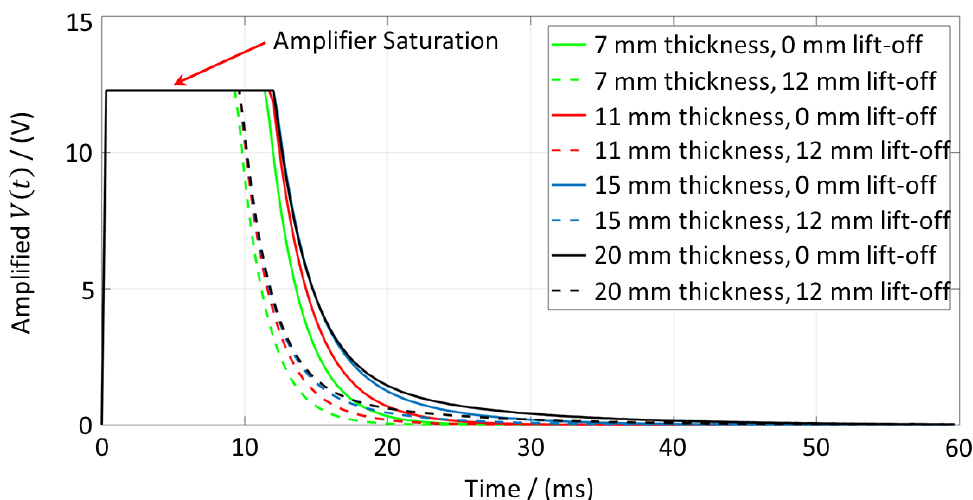
Figure 3. Experimentally captured PEC signals used for the work of this